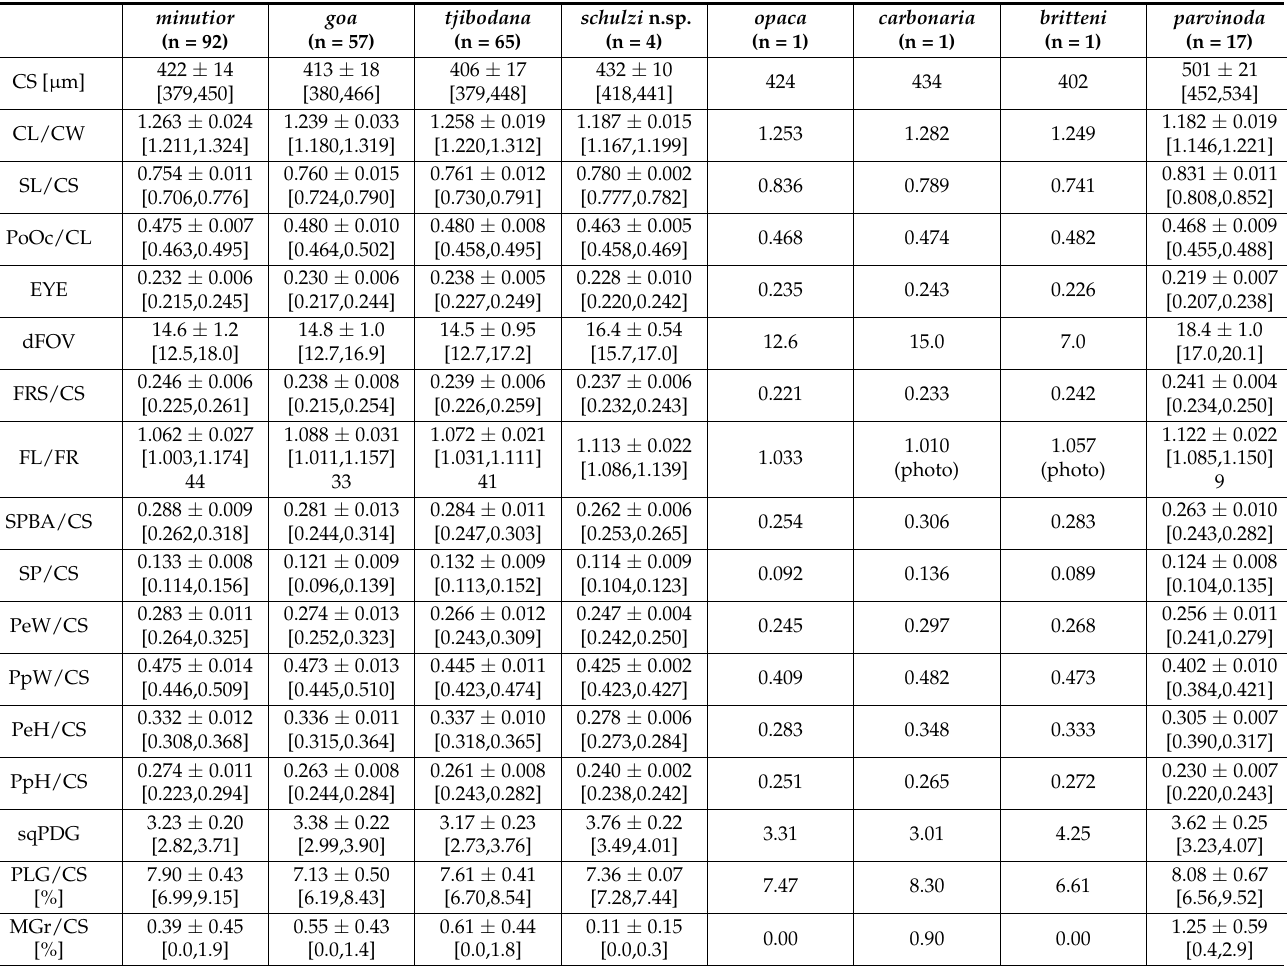
Table 1. Measurements of workers of the Cardiocondyla minutior group. Data are given in the sequence arithmetic mean ± standard deviation [minimum, maximum]. For characters with fewer data than indicated in the head of the columns, the number of measurements is given after the square